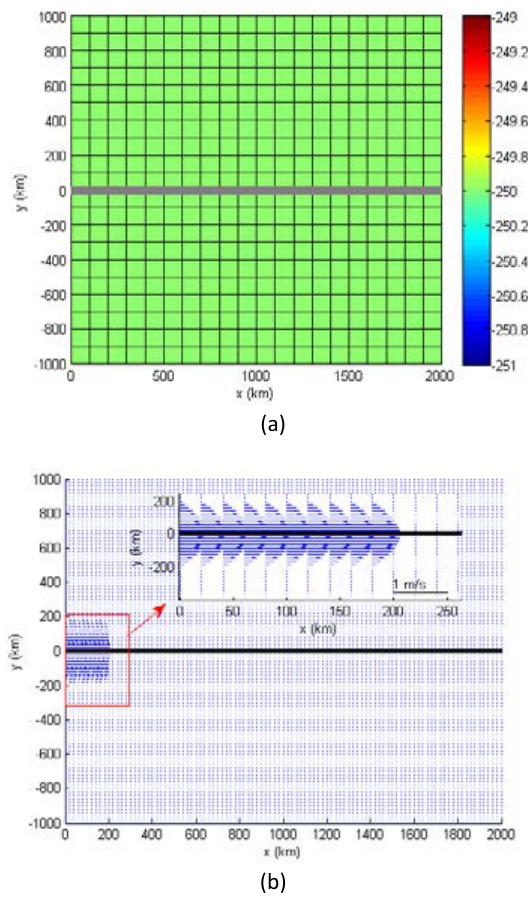
Fig. 1: Model setup (a) domain model, (b) wind stress force